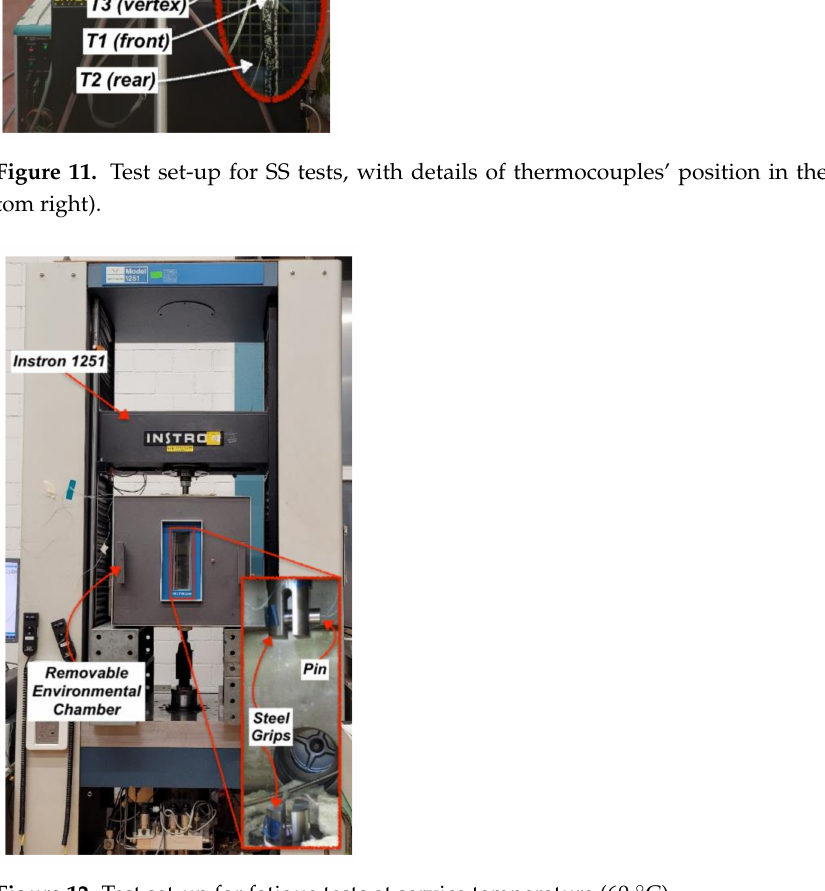
Figure 12. Test set-up for fatigue tests at service temperature (60 ◦